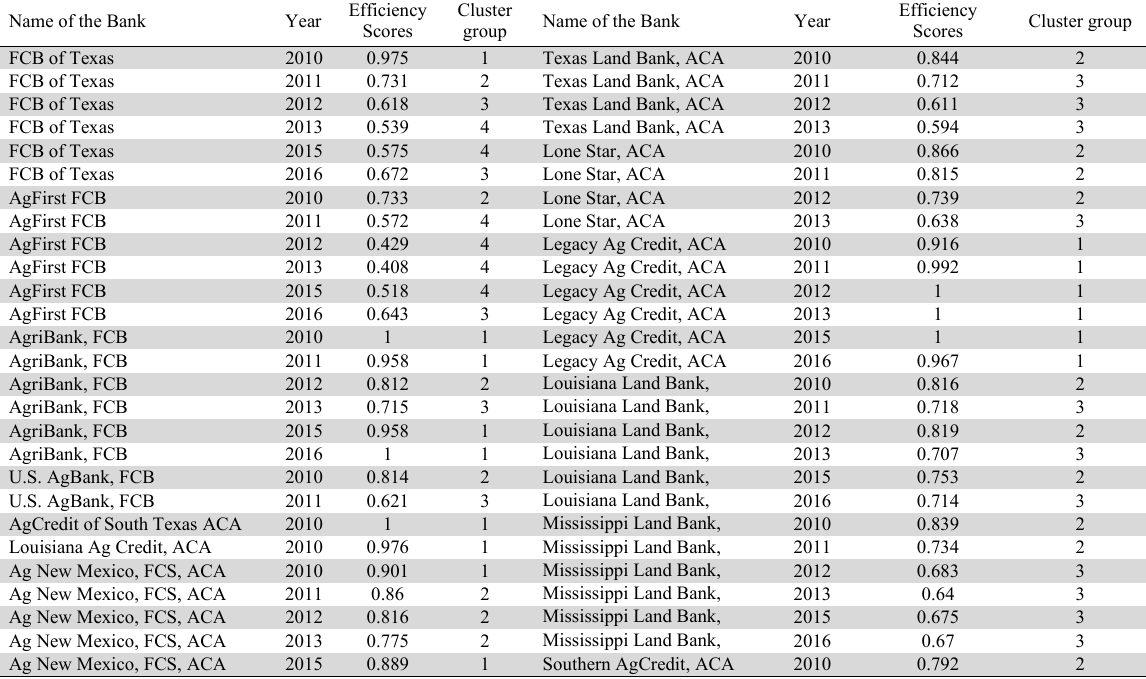
Efficiency Measure